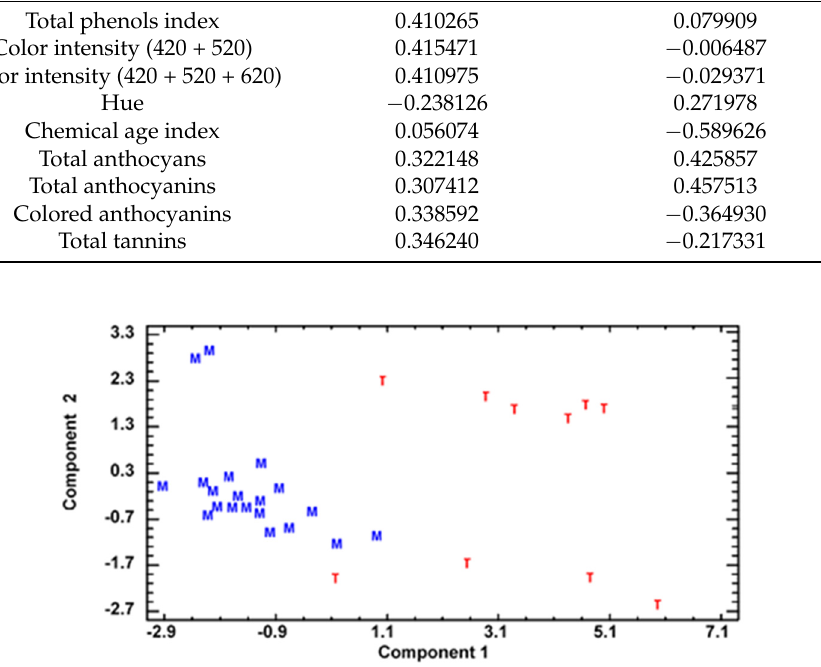
Figure 1. Dispersion plot of principal components 1 and 2 for spectrophotometric data obtained for Mencia (M) and Alicante Bouschet (T) wines.